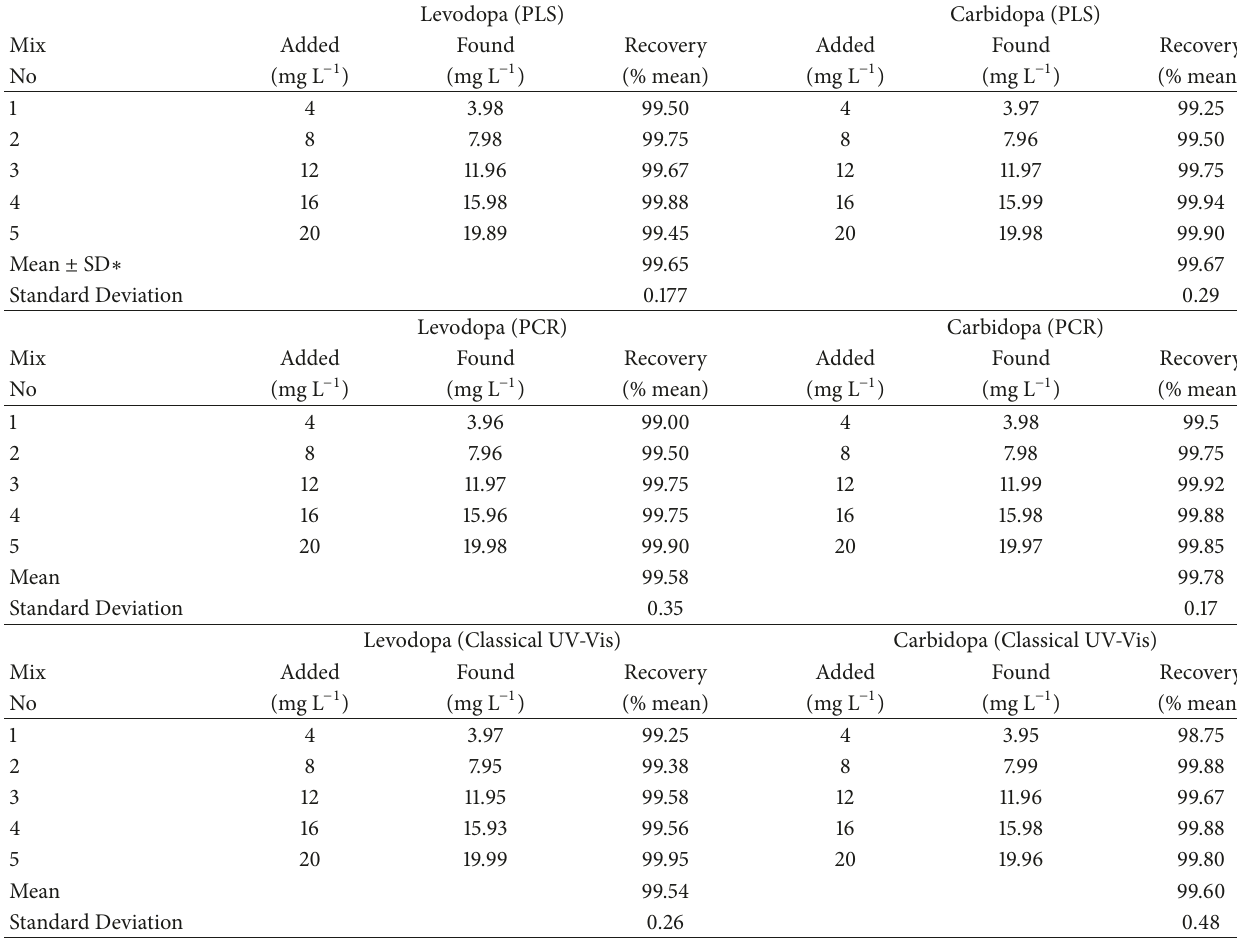
Table 4: Determination of levodopa and carbidopa in human urine using PLS and PCR methods. Levodopa